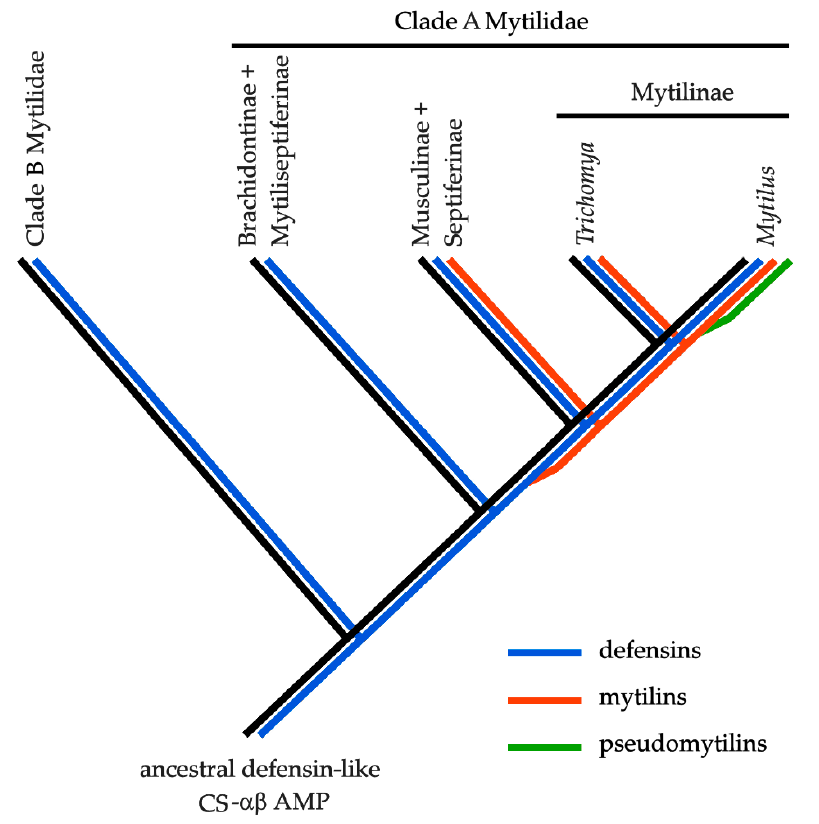
Figure 2. Hypothetical evolutionary scenario of the Mytilidae CS- αβ antimicrobial peptides, based on the presence / absence patterns observed in publicly available -omic data. In brief, an ancestral defensin-like gene is expected to have supported the prototypical structural sca ff old for the development of all the CS- αβ AMPs currently found in extant mussel species. Mytilins are expected to have been originated by a gene duplication event that might have occurred within clade B (see Morton et al., 2019), after the split between Brachidontinae and Mytiseptiferinae from the other three subfamilies. The evolutionary origin of pseudomytilins is expected to have occurred much more recently, possibly soon after the split between the Mytilus and Trichomya lineages.